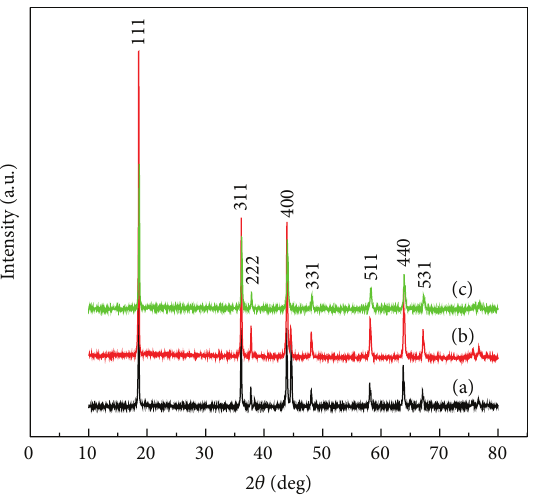
Figure 1: The XRD patterns of (a) LiMn 2 O 4 , (b) Li 1.02 Mn 1.92 Al 0.02 Fe 0.02 Cr 0.02 O 3.92 F 0.08 , and (c) Li 1.02 Mn 1.92 Al 0.02 Fe 0.02 Cr 0.02 O 4 ob- tained by the high temperature solid-state reaction.